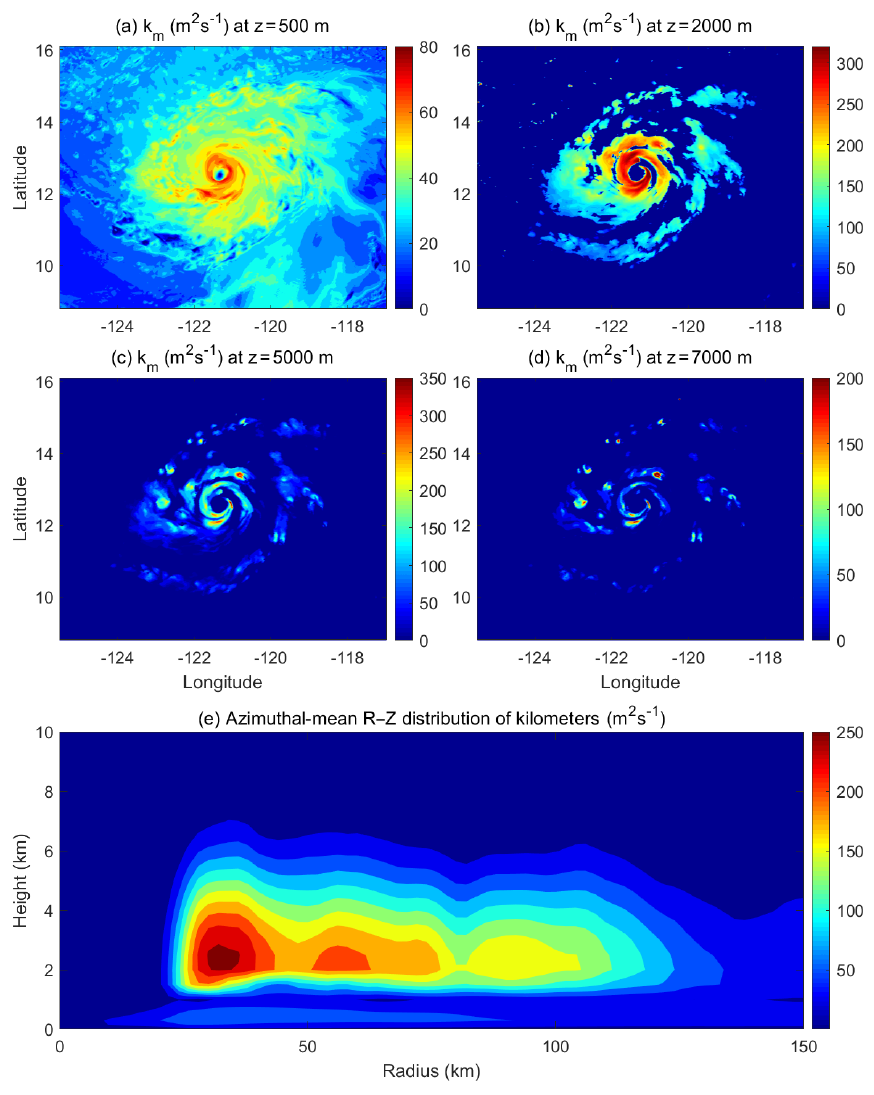
Figure 6. (a) – (d) Horizontal distribution of eddy exchange coefficients of momentum ( k m ) at the altitudes of z = 0 . 5, 2.0, 5.0, and 7.0km, respectively. (e) Azimuthal-mean radius–height distribution of k m from the HWRF simulation with the inclusion of an in-cloud turbulent- mixing parameterization (TL-HWRF) at 12:00UTC, 28 August